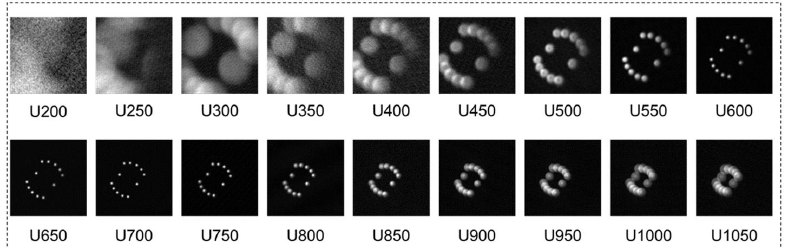
Figure 10. The reconstructed images of the lamp at different depths using the single-pixel imaging method with the CCD as a single-pixel detector.